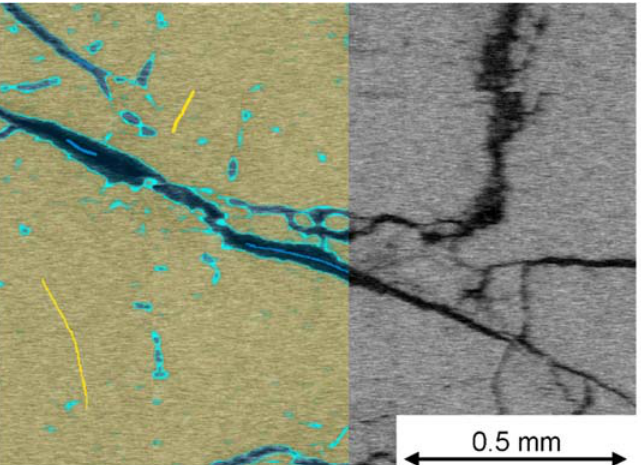
Figure 2. Example image of sample 71 (TD = 75%; heated up to 800 ◦ C) showing the pixel classification. To the left, the yellow lines are user manual annotations of grain area, and the yellow surface is the predicted grain pixels. The blue lines inside the fractures are user manual annotations for fractures, and the light blue surface is the pixels interpreted as fractures. The original SEM image is to the right.